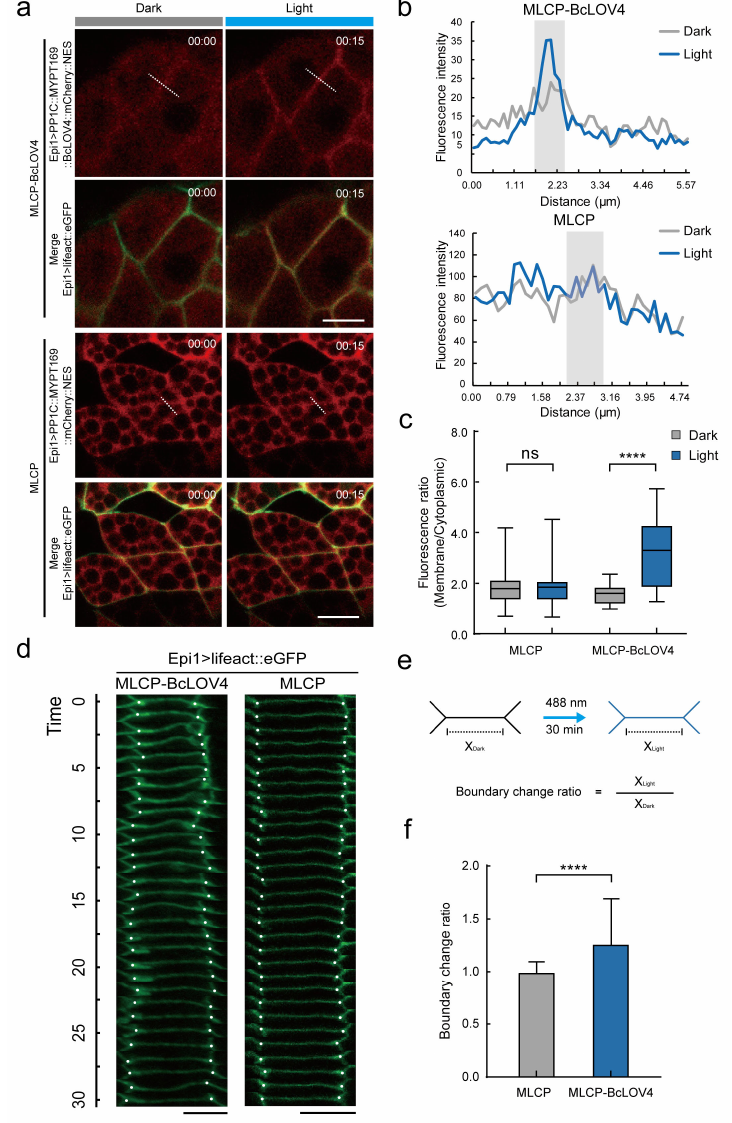
Figure 3. MLCP ‐ BcLOV4 system suppressed the contractility of epidermal cells in Ciona embryos. Figure 3. MLCP-BcLOV4 system suppressed the contractility of epidermal cells in Ciona em- ( a ) Representative images of the expression of the MLCP ‐ BcLOV4 ‐ expressed group bryos. ( a ) Representative images of the expression of the MLCP-BcLOV4-expressed group (Epi1>PP1c::MYPT169::BcLOV4::mCherry::NES, top two rows) and the MLCP-expressed group (Epi1>PP1c::MYPT169::mCherry::NES, bottom two rows) in the epidermis of Ciona embryos. On the left are images in the dark and on the right are images after 15 min of illumination under 488 nm blue light. Scale bar, 5 µ m; ( b ) Quantitative statistics of fluorescence intensity at the white dotted line in panel a. The gray line is the statistical graph in the dark state and the blue line is the statistical graph after 15 min of blue light irradiation. The light gray area is the cell boundary; ( c ) Quantification of membrane-to-cytoplasm ratio of mCherry signal fluorescence of the MLCP-BcLOV4-expressed group and the MLCP-expressed group after 15 min of exposure to 0.5% blue light. ****, p < 0.0001 (student’s t -test). n = 20 cells; ( d ) Representative images of epidermal cell boundary length over time in Ciona embryos from the MLCP-BcLOV4-expressed group and MLCP-expressed group during a 30 min period. White dots show the location of tricellular junctions. Scale bar, 5 µ m; ( e ) Schematic diagram of boundary change ratio calculation; ( f ) The boundary change ratio of epidermal cells in the MLCP-BcLOV4-expressed group and MLCP-expressed group after 30 min of blue light irradiation. ****, p < 0.0001 (student’s t -test). n = 100